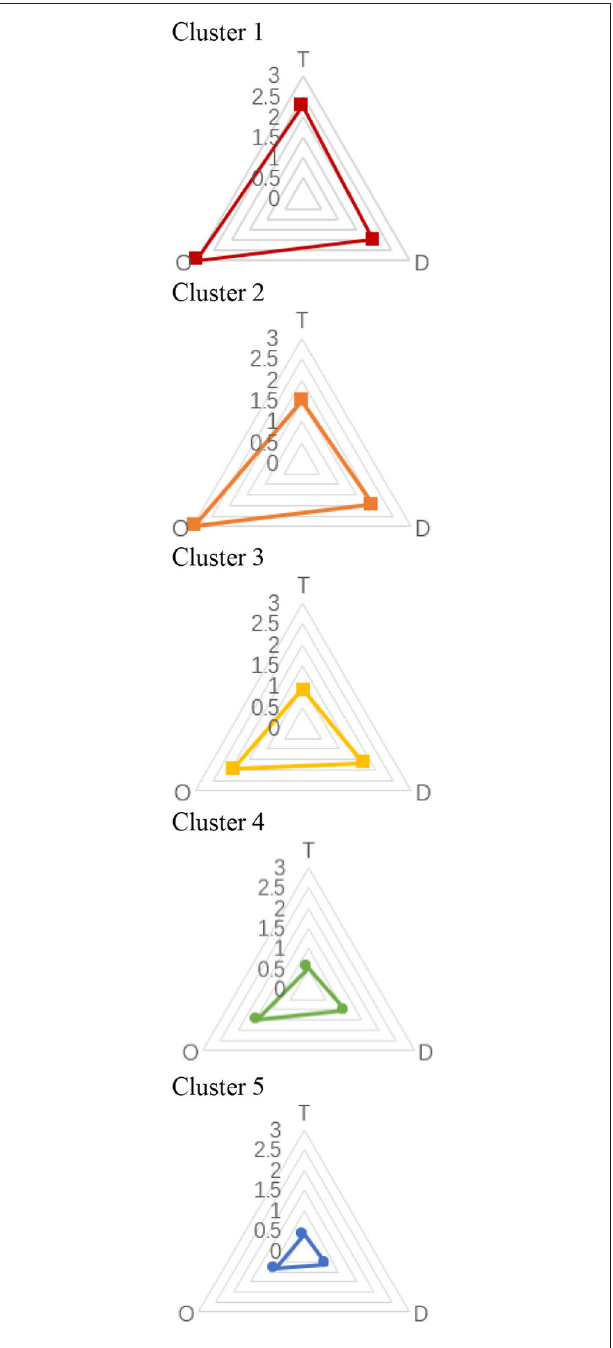
FIGURE 9 | Rader charts for each variable by